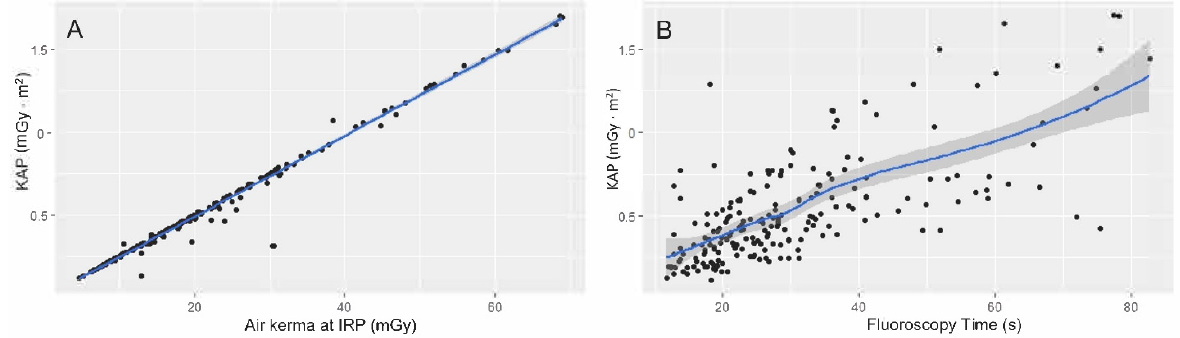
Figure 1. Linear regression of air kerma at IRP with KAP ( A ) and fluoroscopy time with KAP ( B ). A positive linear association was observed in both cases.